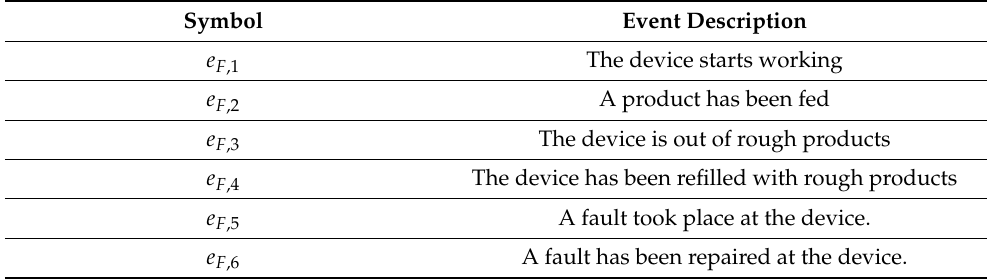
Table 12. Events of the feeding device.